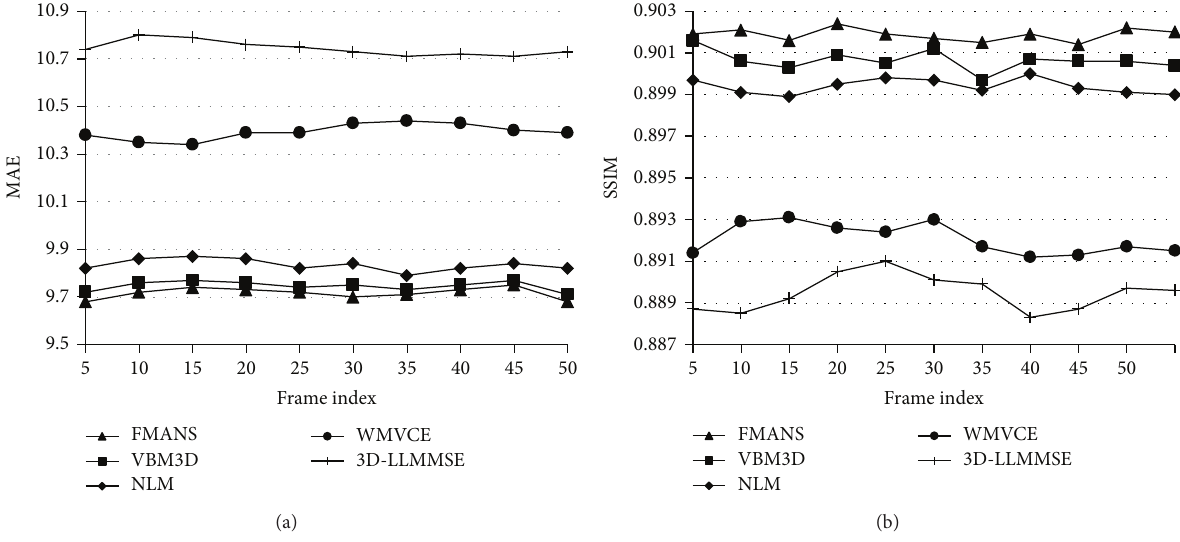
Figure 5: MAE for the different methods applied to (a) Foreman ( 𝜎 2 = 0.020 ) and SSIM for the different methods applied to (b) Stefan ( 𝜎 2 = 0.005